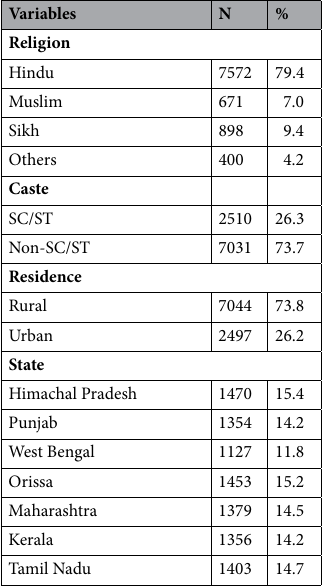
Table 1. Sample distribution of study population, India. N: sample, %: percentage, SC/ST: scheduled caste/ scheduled